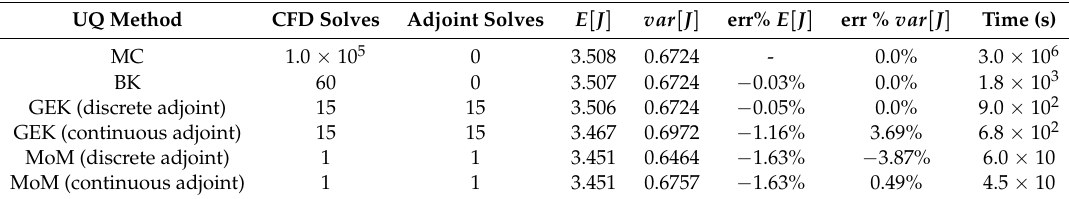
Table 3. Accuracy and computational efficiency of the UQ